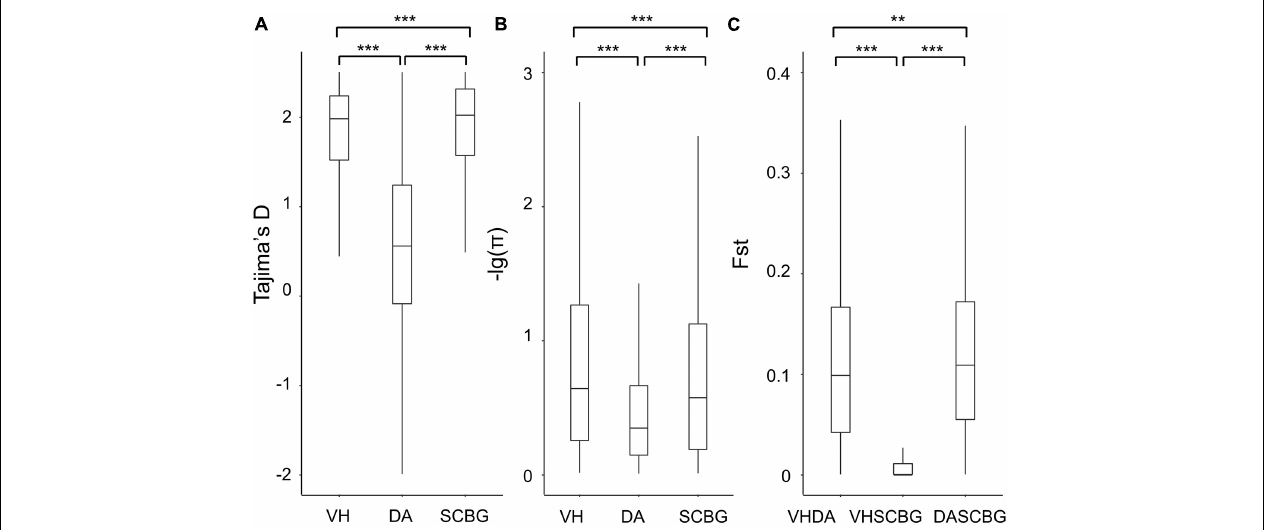
FIGURE 2 | Boxplots of Tajima’s D (A) , genetic diversity ( π ) (B) , and relative divergence (Fst) (C) between populations with non-overlap 100-kb windows. VH, DA, and SCBG present populations from Vinh Yen, Vietnam; Hainan Island, China; and Guangzhou, China, respectively. Outliers are not shown. Significance of Wilcoxon rank-sum test are presented on the top (**0.01 < p < 0.05; *** p <